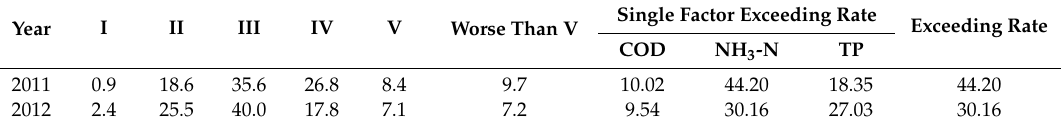
Table 1. Water quality information for the Taihu Lake Basin in Jiangsu Province (unit: %).